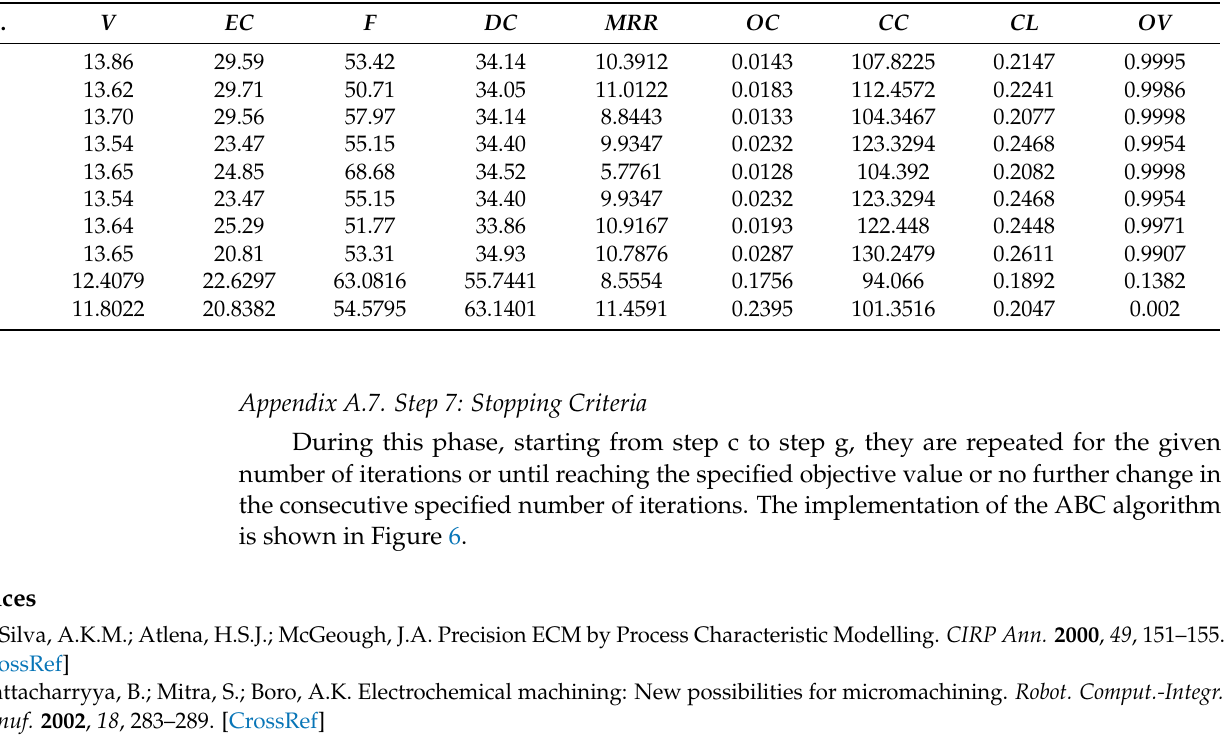
Table A17. Replaced